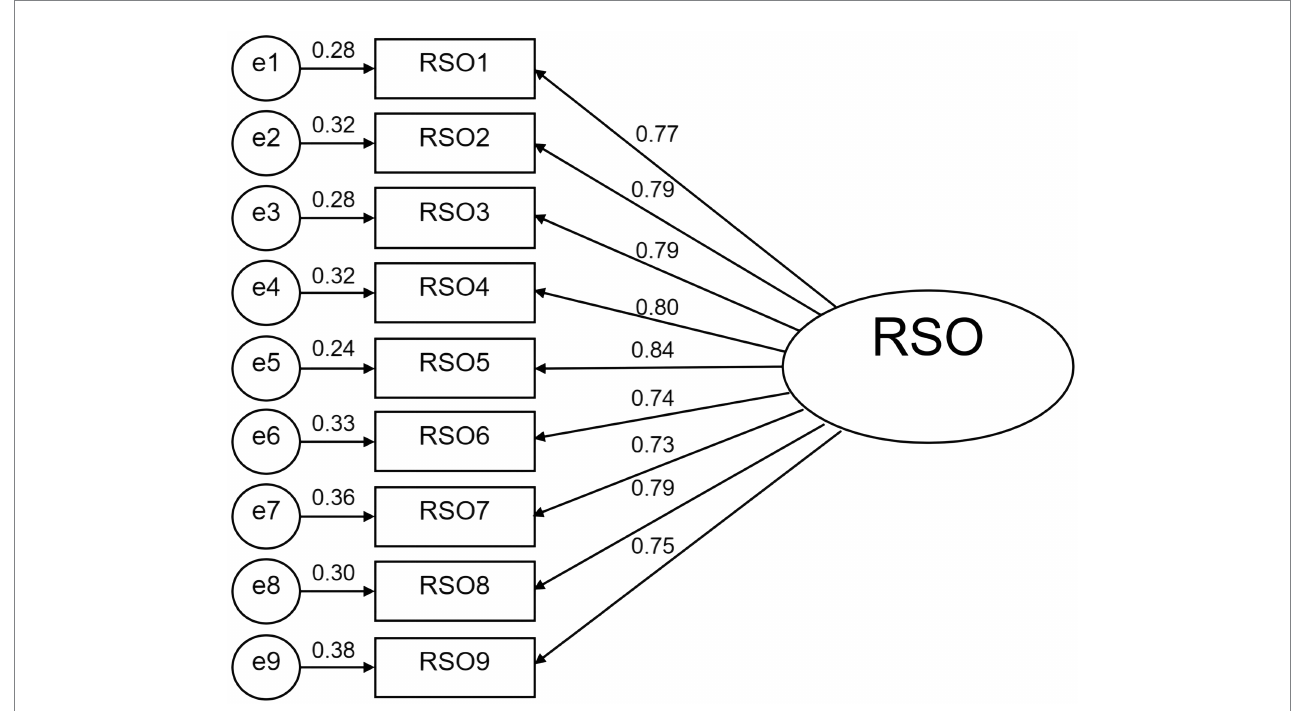
FIGURE 1 Results of the confirmatory factor analysis for RSO including a single factor.